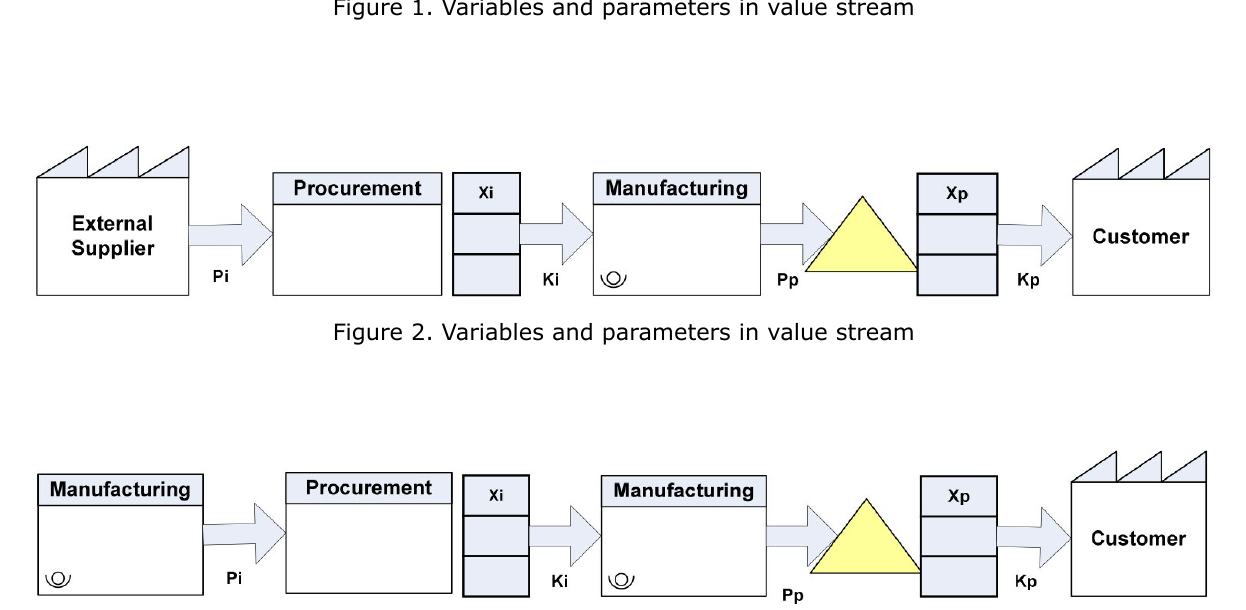
Figure 3. Variables and parameters in value